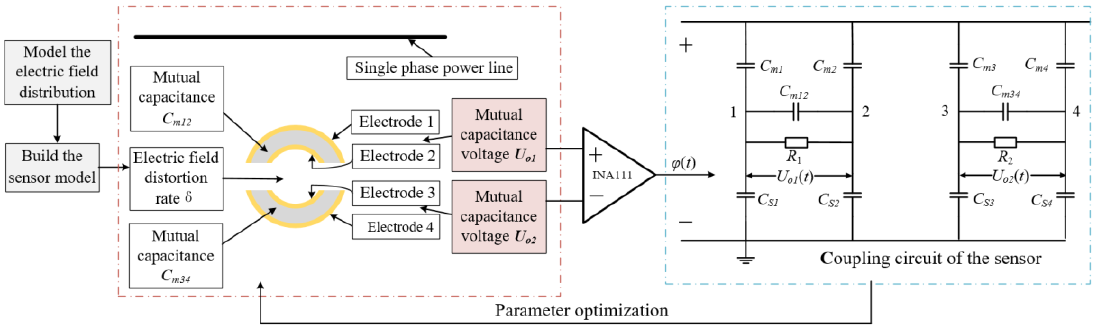
Figure 4. Implementation steps of Field-Circuit Coupling method.